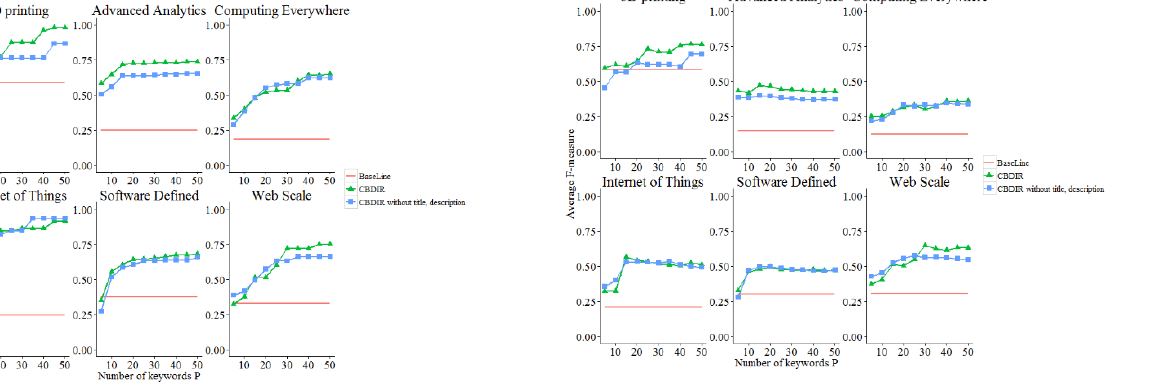
Fig. 4. Performance Evaluation - Average Recall in each category across the number of keywords (red: baseline, green: CBDIR, blue line: CBDIR without the title and description information)